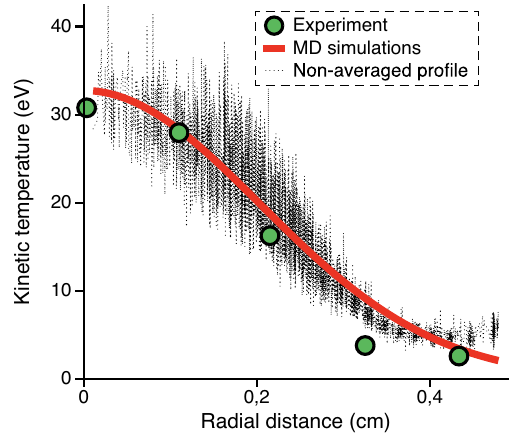
Figure 8. Comparison of the radial profiles of kinetic energy obtained in this work experimentally and in MD simulations. The simulated dusty plasma system has the parameters Q β/α 230 , γ 1.8 s − 1 = =